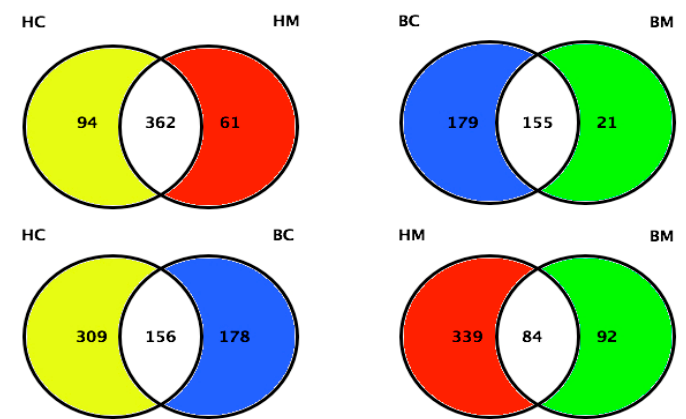
Figure 6. Quantitative comparison of MFGM proteins between human colostrum and human mature milk, bovine colostrum and bovine mature milk, human colostrum and bovine colostrum, and human mature milk and bovine mature milk (HC = human colostrum; HM = human mature milk; BC = bovine colostrum; BM = bovine mature milk). Adapted from Cao et al., 2019 [68].